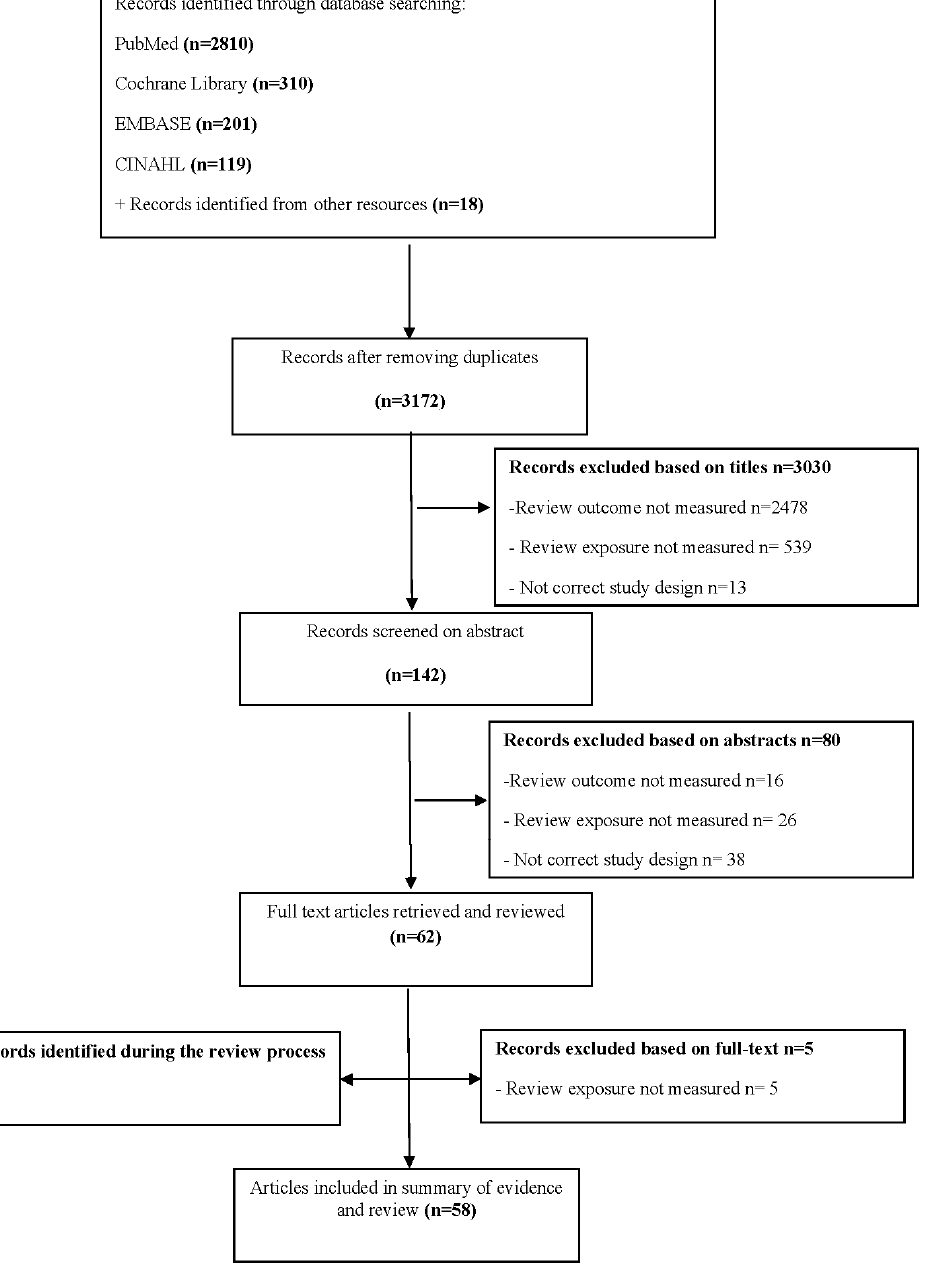
Figure 2. Preferred Reporting Items for Systematic Reviews and Meta ‐ Analysis (PRISMA) flowchart of studies to include in systematic review of the association between fruit and vegetable intake and asthma.